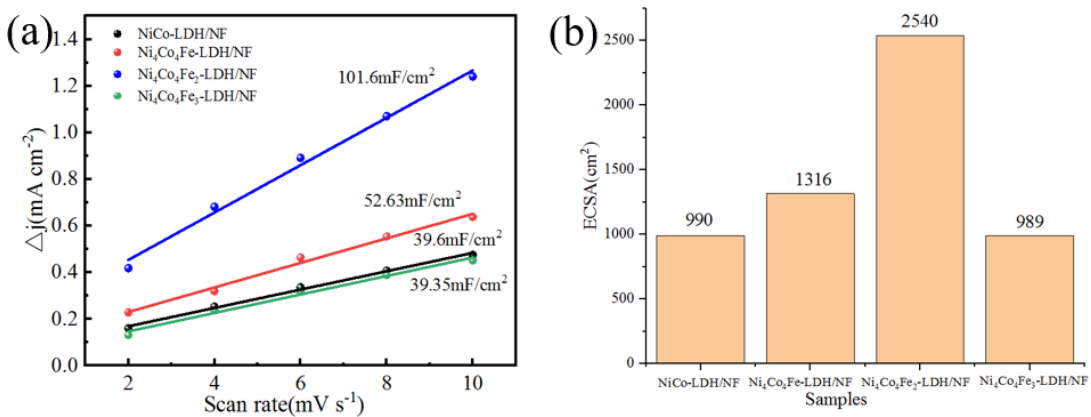
Figure 8. ( a ) C dl and ( b ) ECSA of Ni − Co based LDH electrode catalysts